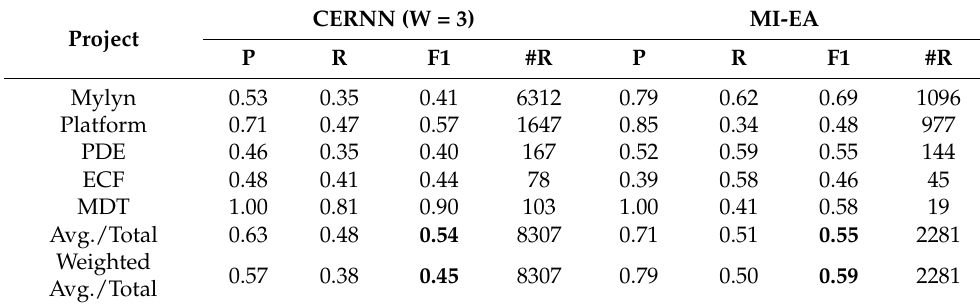
Table 3. Comparison of the recommendation accuracies of CERNN (W = 3) and MI-EA.